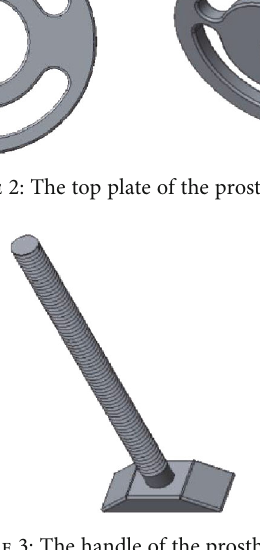
Figure 3: The handle of the prosthesis.